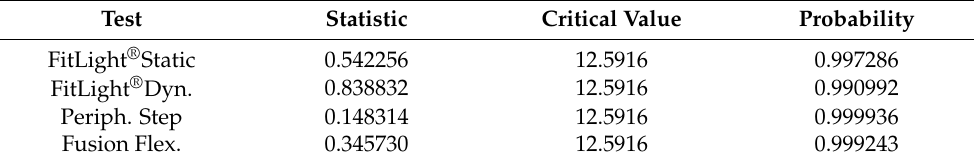
Table 3. Overview of outcomes of group independence testing for the Visuo-spatial-motor